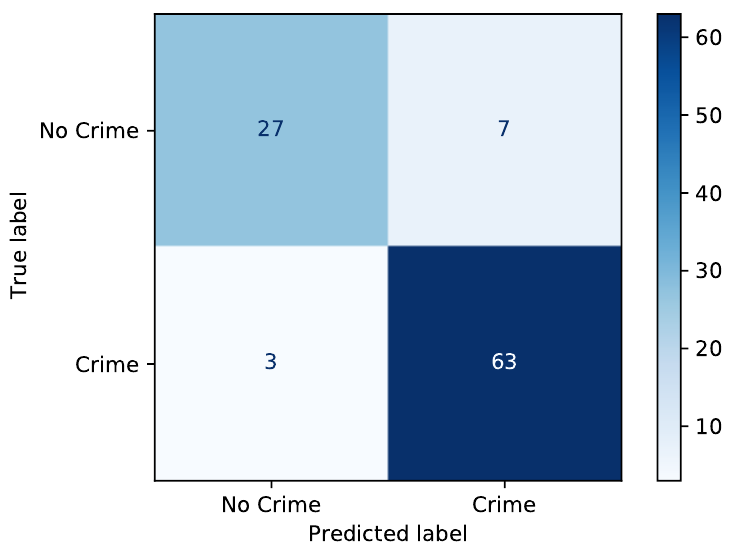
Figure 6. Confusion matrix for Xception on the test dataset.